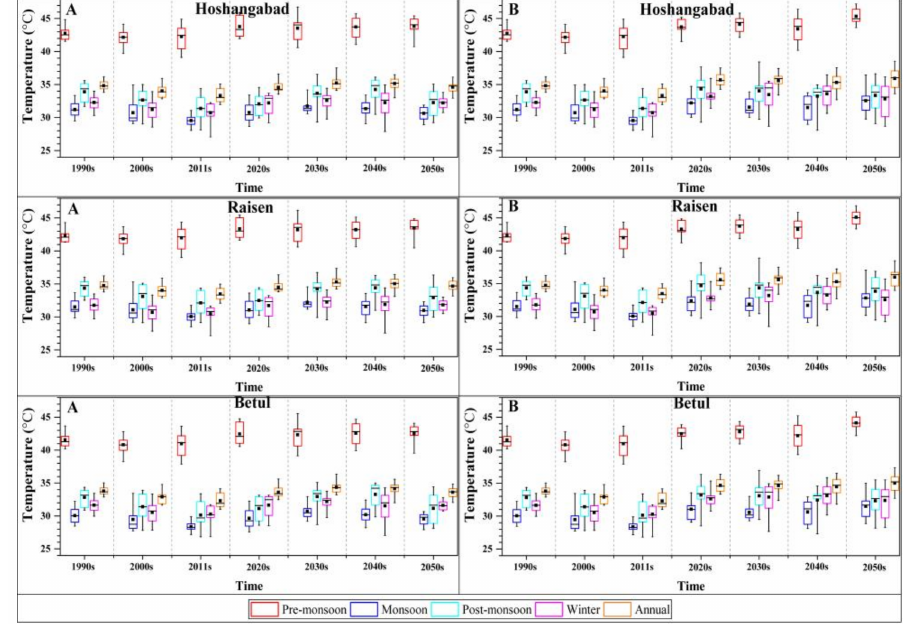
Figure 8. Maximum temperature of past and future (1990s to 2050s) using ACCESS1 of CMIP5 and scenarios are A = RCP4.5 and B = RCP8.5.